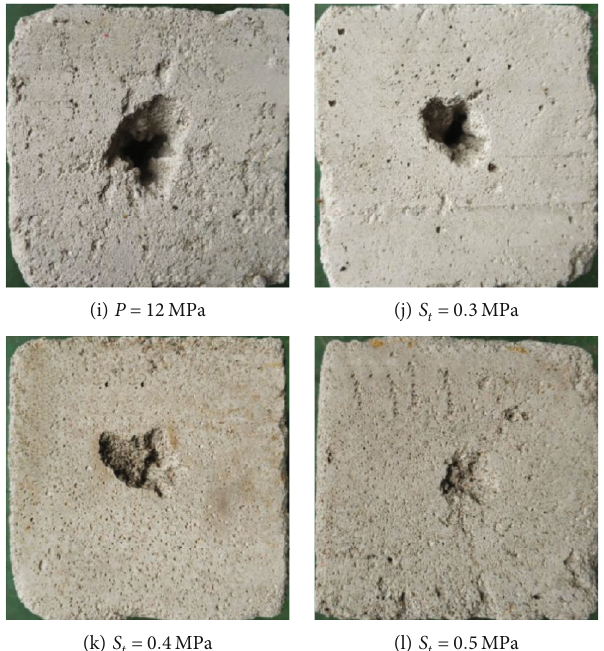
Figure 9: Shape of erosion pit formed by di ff erent jet parameters (Ma, H , P , S